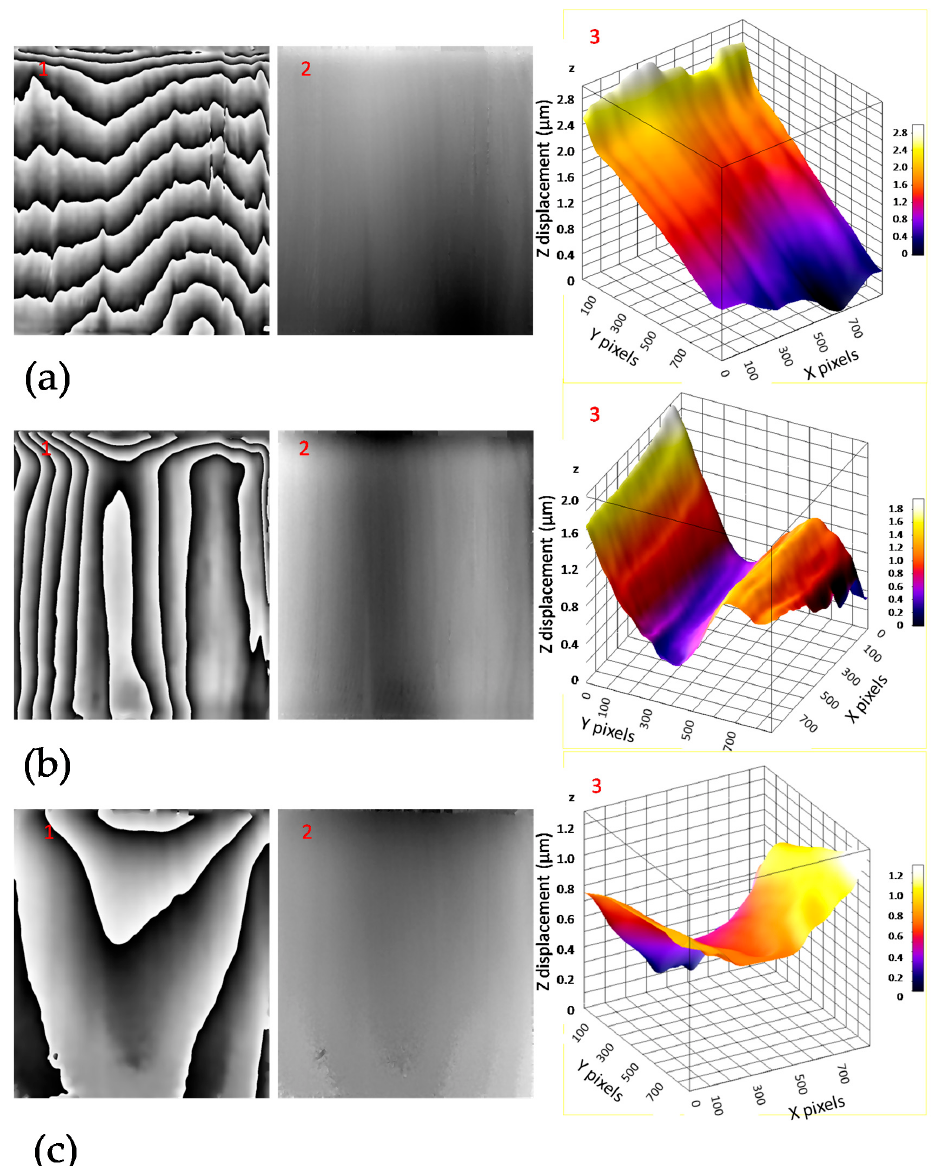
Figure 8. Examples of filtered interferograms (1), the unwrapped-phase (2) and three-dimensional surface deformation maps (3), data related to Figure 6, at ( a ) 12 minutes after the beginning of the cycle (drying), ( b ) 231 minutes from the beginning of the cycle (rehydration start) and ( c ) 416 minutes from the beginning of the cycle (mass characteristic plateau). (In plot 8b3 the x,y axes are rotated in order to show better the surface displacement).